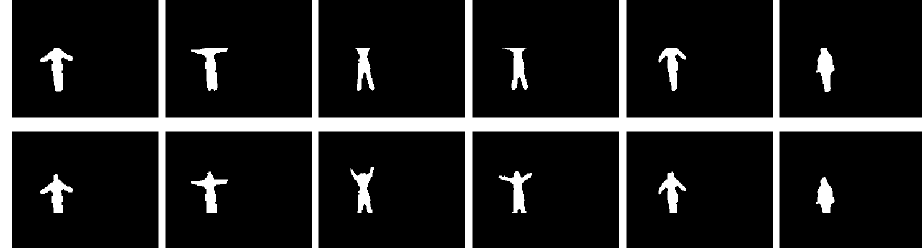
Figure 4. Foreground masks for a jumping-jack action with added